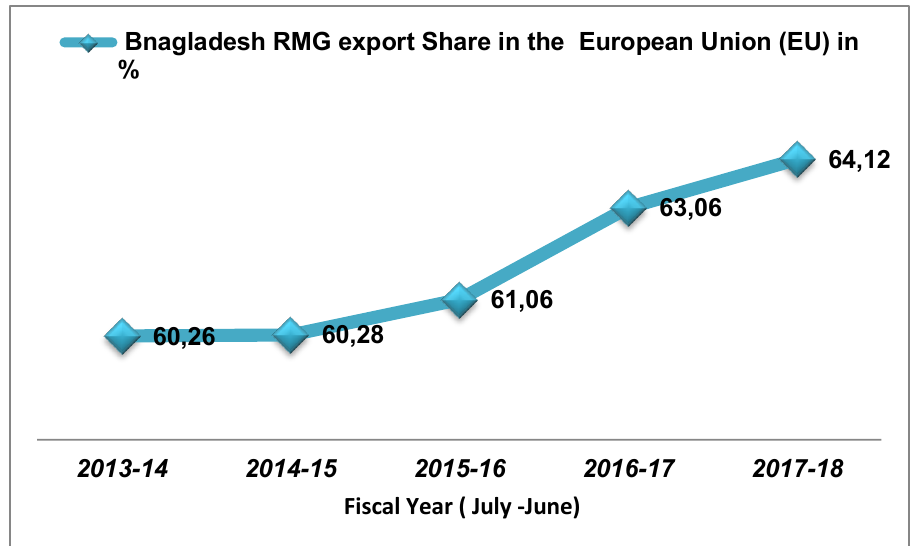
Figure 1: Bangladesh RMG Export Share in the EU Market (out of its total global RMG export share) Source: Calculated based on EPB Database,